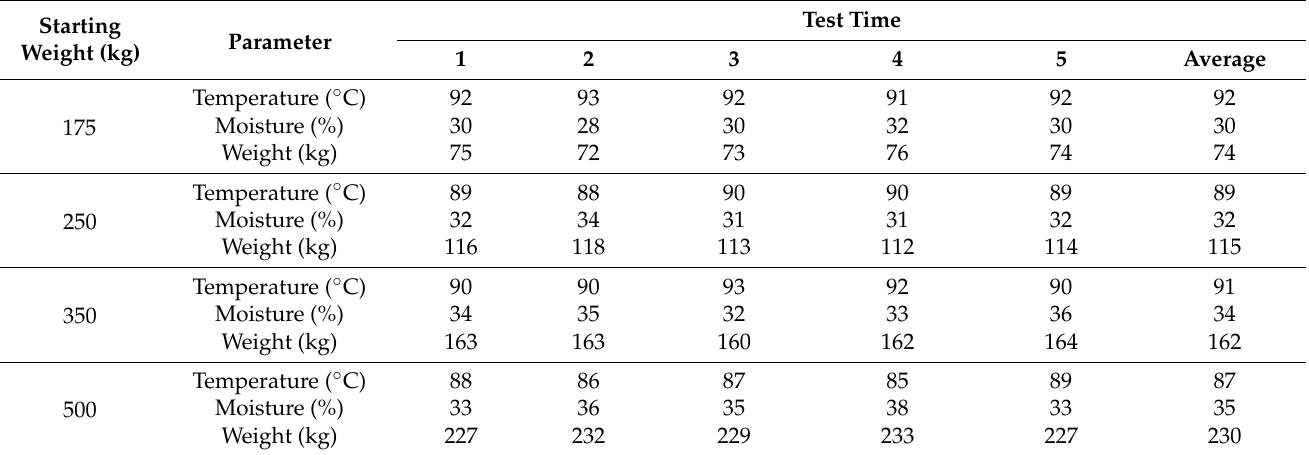
Table 5. Resulting temperature, moisture, and weight after heating for 20 h.